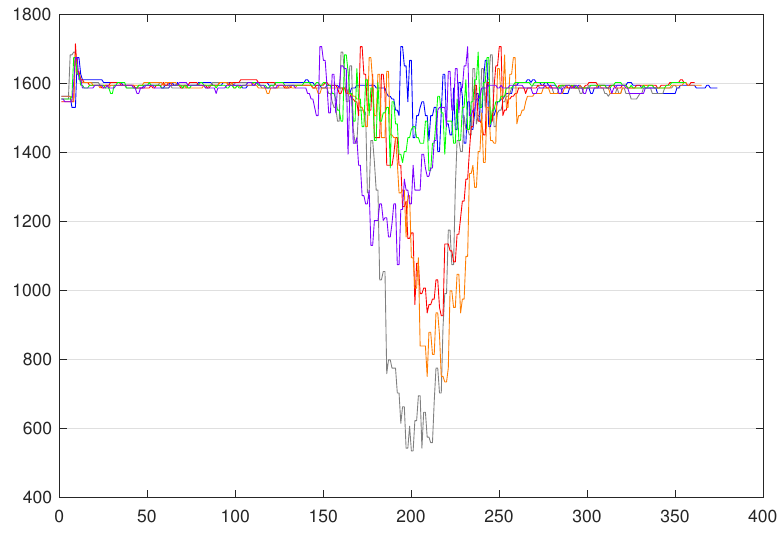
Figure 6. 6 colours TS with no preprocessing.